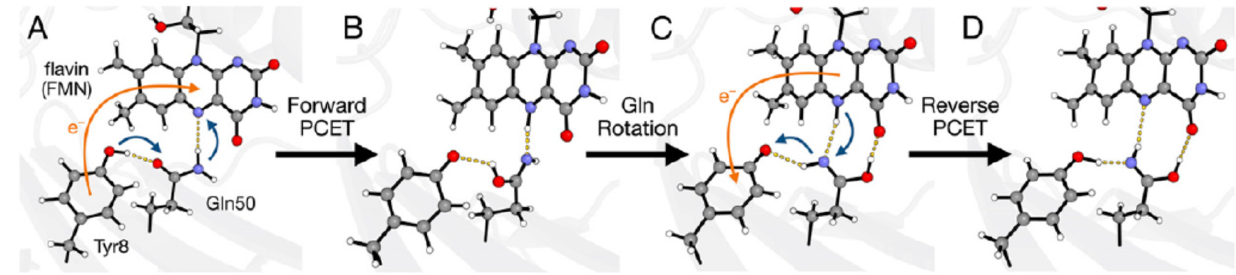
Figure 20. The photocycle of BLUF photoreceptor [228]. ©2020 National Academy of Sciences of the United States of America.